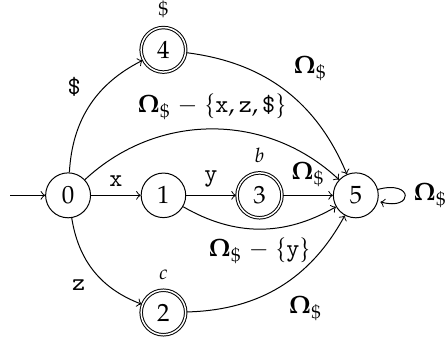
Figure 2. The scanner automaton 9 M T